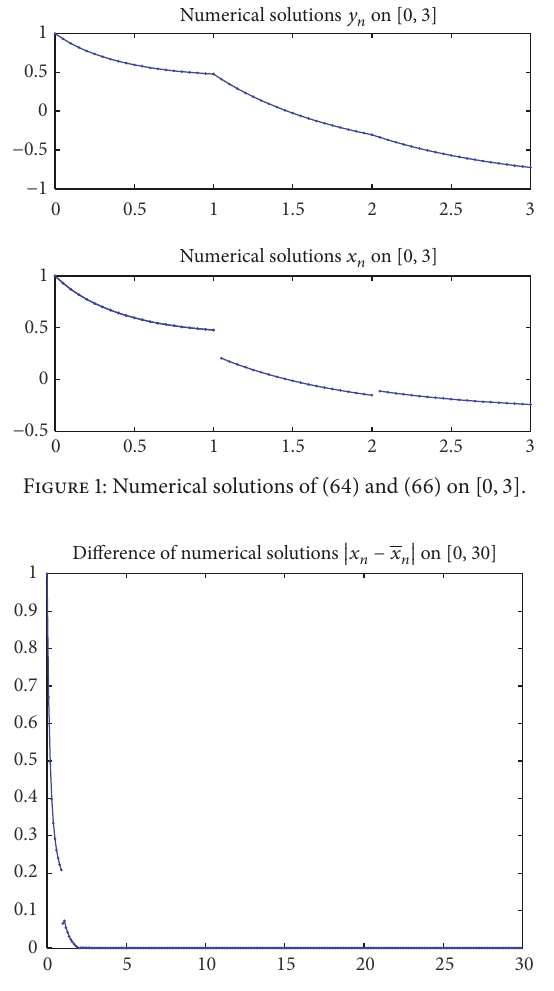
Figure 2: The difference of numerical solutions to (64) and (65) on [0,30]